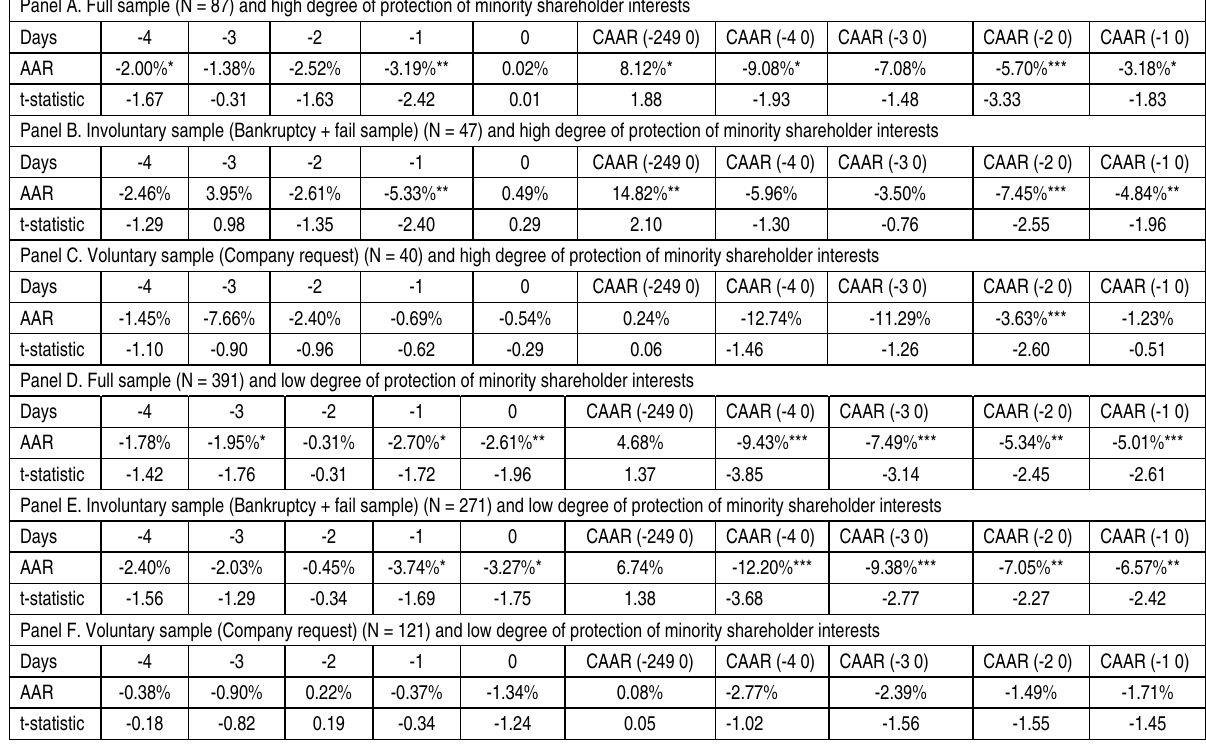
Table 5. Average abnormal returns and cumulative average abnormal returns around delistings announcement days, based on the degree of protection of minority shareholder interests